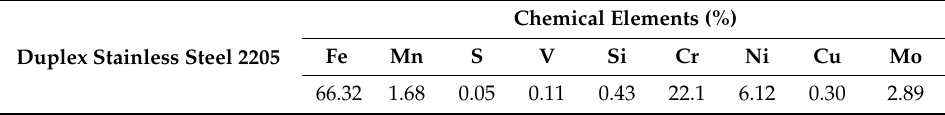
Figure 1. Experimental set up showing a three-electrode cell with nitrogen gas layer to maintain anaerobic test conditions. Table 1. Chemical composition of DSS 2205.